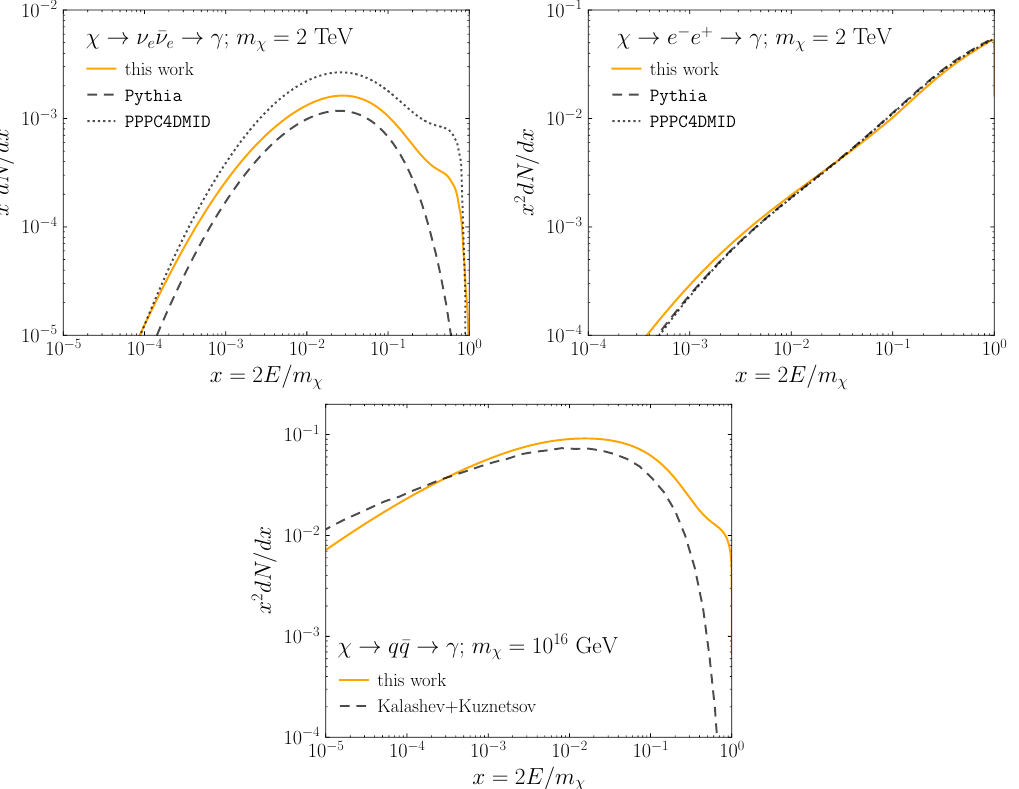
Figure 4 . A comparison between the results of the present work and alternative approaches to calculating heavy DM spectra. The top left figure is an analogue of figure 1 for the photon spectrum, but for a DM mass of m = 2 TeV. Even at this lower mass, the additional electroweak effects in χ our calculation are producing clear differences with Pythia . We also demonstrate that our spectra differ from those in PPPC4DMID , a point further discussed in the text. The disagreement is not generic, however, and instead restricted to scenarios where the initial decay involves neutrinos. We show a single example in the top right, showing significantly improved agreement, and in general for these other channels the agreement is within the uncertainty we have ascribed to our results. On the bottom we show photon spectra for GUT scale DM ( m = 10 16 GeV) decaying to light quarks, χ q = ( u + d + s ) / 3 . Here our spectrum is compared to results obtained using pure QCD DGLAP of a low energy fragmentation function, taken from figure 1 in ref. [93]. Even for this hadronic channel, there is a clear difference in the hard photon contribution associated with electroweak evolution